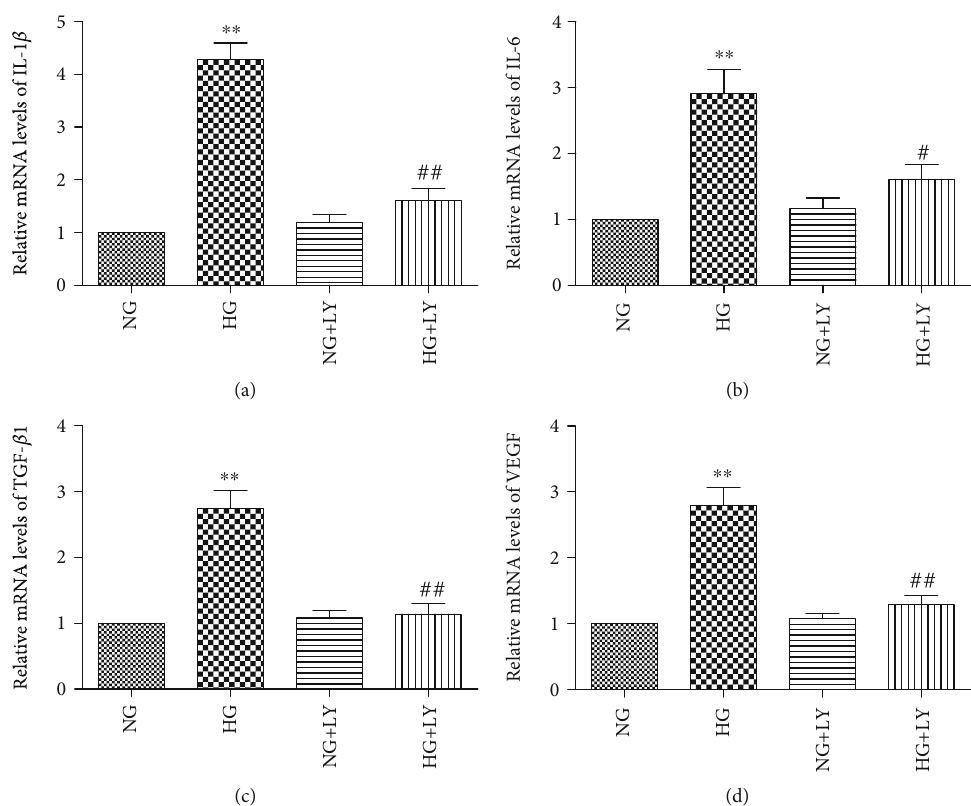
Figure 6: Inhibition of Akt signalling downregulated HG-induced IL-1 β , IL-6, TGF- β 1, and VEGF mRNA expression in RPE cells. RPE cells were preincubated for 1 h with 10 μ M of LY294002 and then stimulated by HG (30 mM) for 24h. The IL-1 β , IL-6, TGF- β 1, and VEGF mRNA levels were determined using real-time PCR. LY294002 signi fi cantly decreased the HG-induced mRNA (a – d) levels of IL-1 β , IL-6, TGF- β 1, and VEGF in RPE cells. The data shown represent the mean ± SD of three independent experiments. ∗∗ p < 0 : 01 versus NG; # p < 0 : 05 versus HG; ## p < 0 : 01 versus